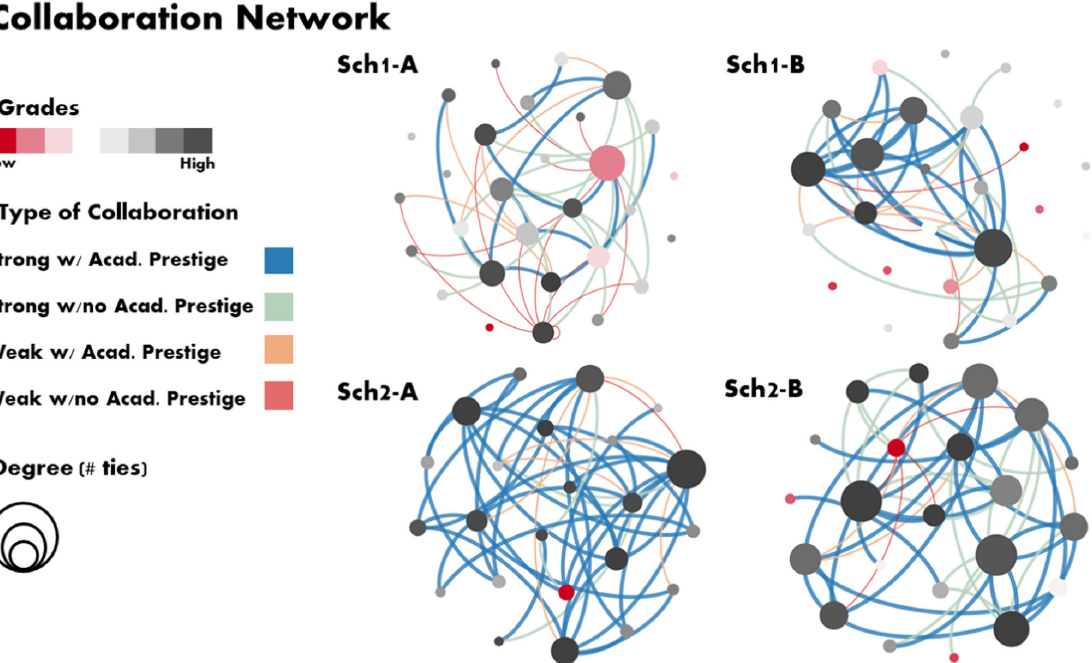
FIG. 2. Collaboration network for physics. Node color represents academic performance from low (red) to high grades (black), while its size indicates degree centrality — number of collaborative ties. Edge or link colors depict the type of collaborative relationship (e.g., blue ties are strong collaboration with high prestige students in physics). Note that by default isolates are set to the size of the lowest